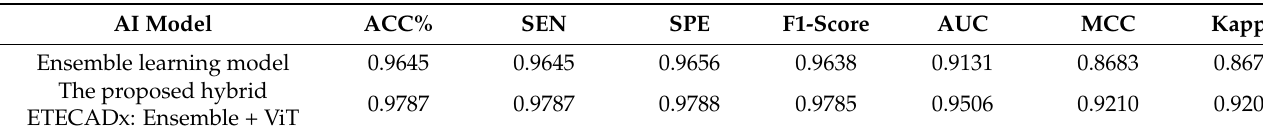
Table 7. Evaluation performance of the proposed ETECADx framework against the ensemble learning model for the multi-class classification approach using the INbreast testing set.